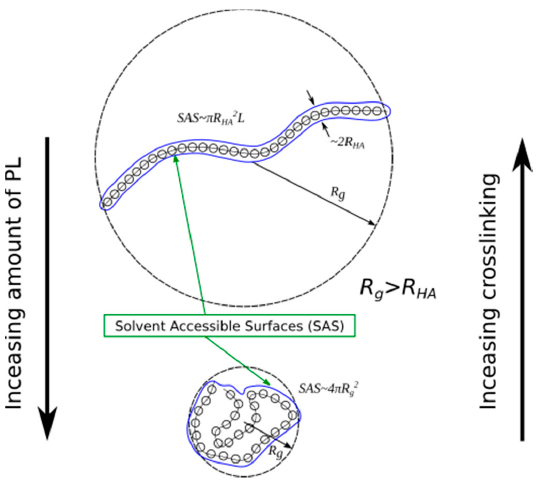
Figure 14. An effect of increasing PL concentration on the solvent-accessible surface and associated crosslinking ability.